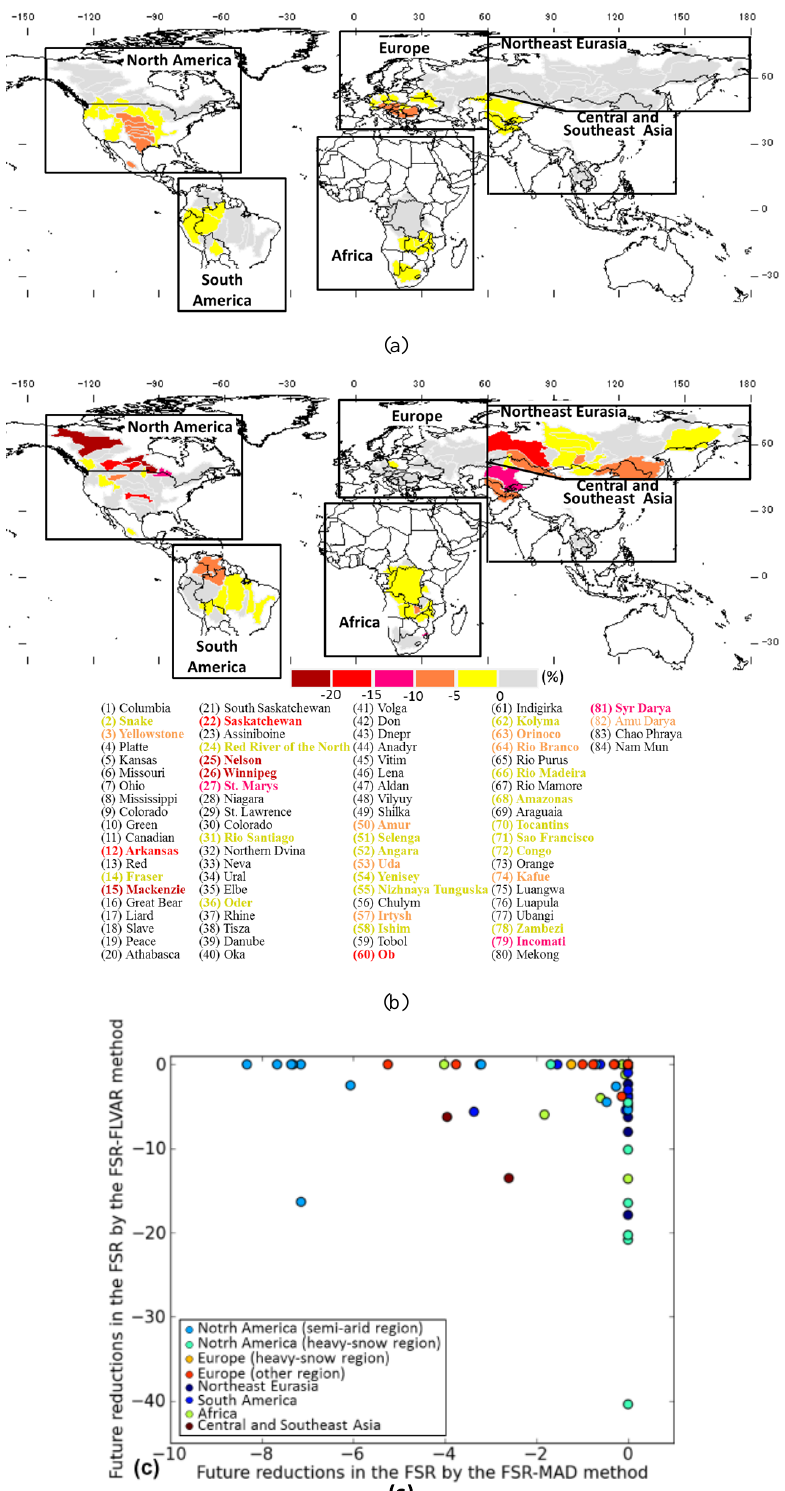
Fig. 2. Global distributions of the median value of future reductions in fish species richness in 84 individual river basins by (a) the FSR-MAD and (b) the FSR-FLVAR methods. (c) Values in (a) and (b) are converted into scatter